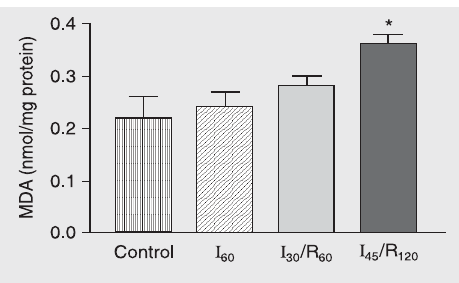
Figure 7. Changes in malondial- dehyde (MDA) concentrations in the liver of mongrel dogs ex- posed to sham operation (con- trol), 60 min of ischemia (I 60 ), 30 min of ischemia followed by 60 min of reperfusion (I 30 /R 60 ), and 45 min of ischemia followed by 120 min of reperfusion (I 45 / R 120 ). Data are reported as means ± SEM, N = 6 per group. Hepatic tissue lipid peroxide lev- els were significantly elevated in group I 45 /R 120 compared to control. Each value represents the mean ± SEM of six experi- ments. *P < 0.05 compared to control